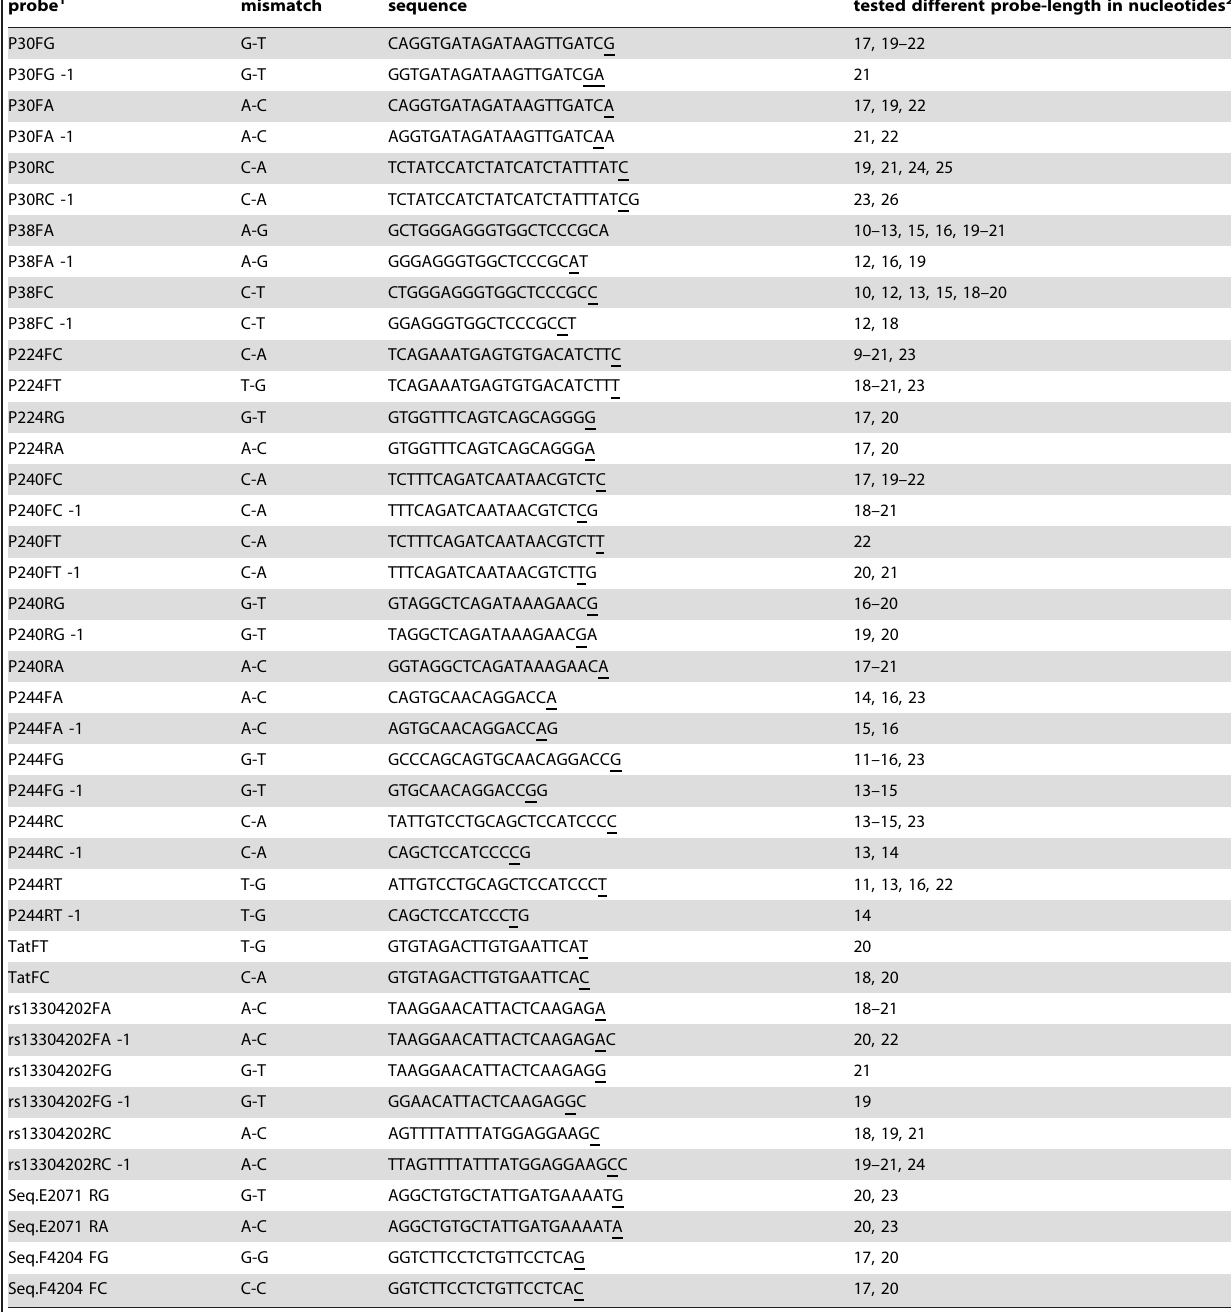
Table 1. Probes tested in